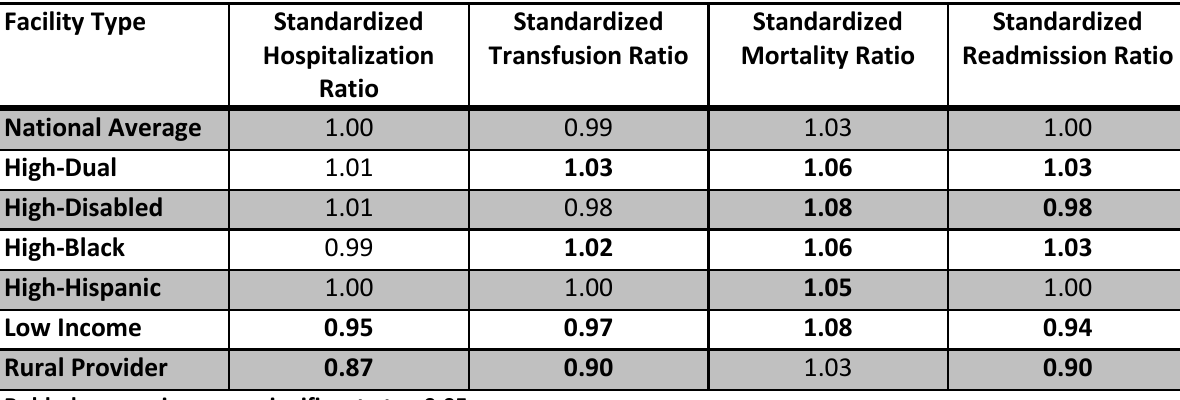
Table 11.8: Standardized Ratio Measures for CY 2015 Performance Measure Period Facility